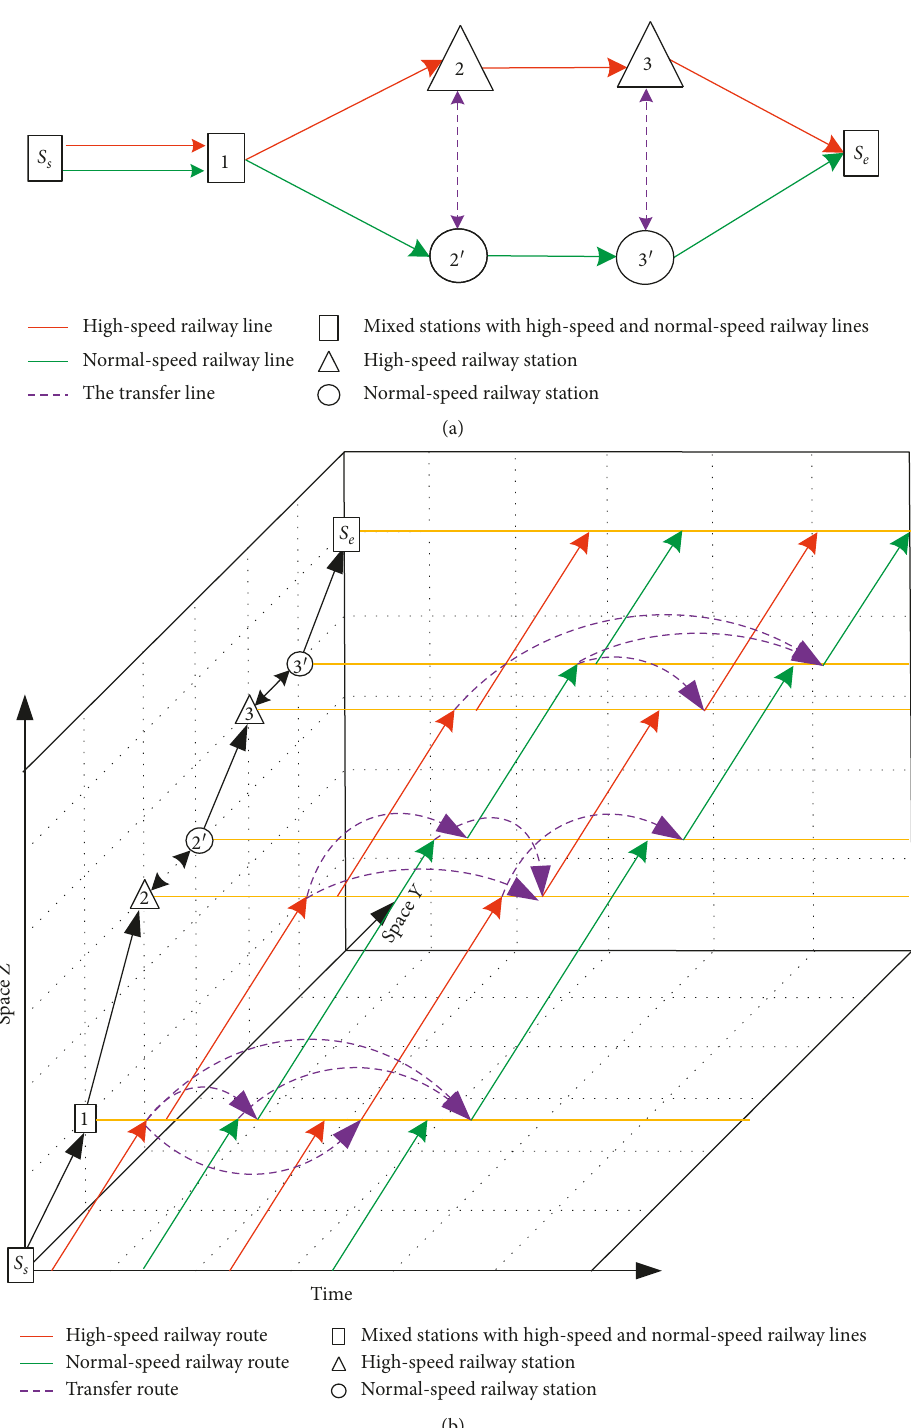
Figure 5: Complex train routes network diagram considering passengers’ travel choice in the context of syncretic railway network. (a) Physical network structure diagram between nodes. (b) A complex train routing network diagram for train